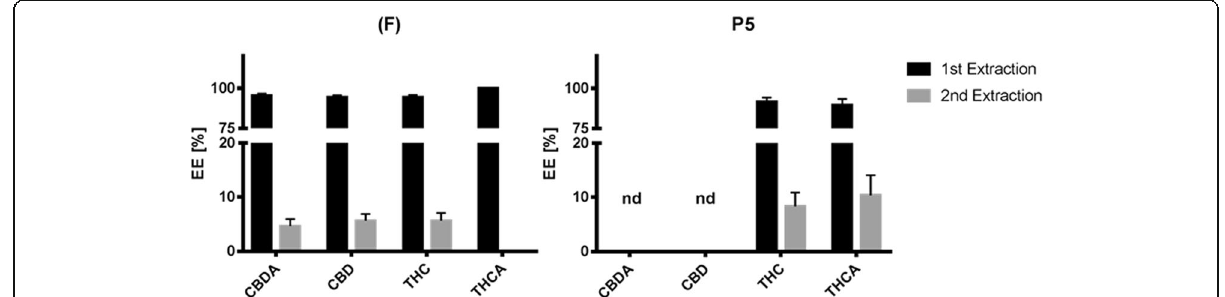
Fig. 4 Extraction efficiency on CBD-rich (F) and THC-rich (P5) cannabis